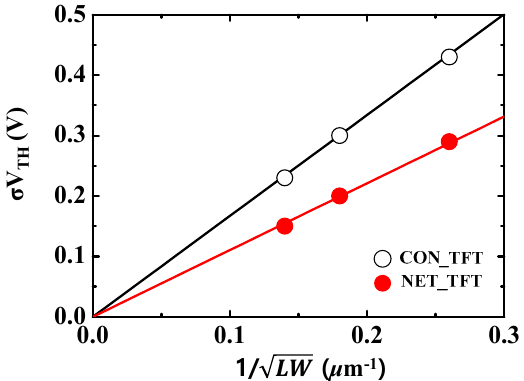
Figure 8. Standard deviation of V TH ( σ V TH ) as a function of LW − 1/2 for both CON and NET_TFTs.